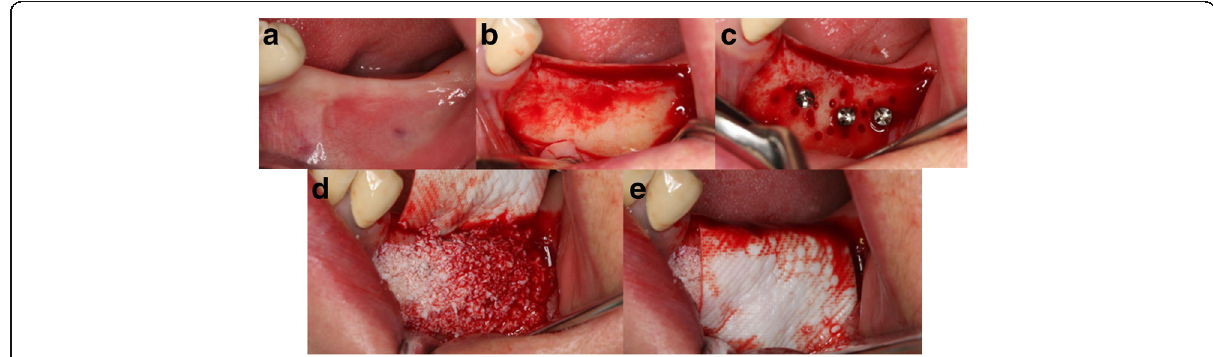
Fig. 1 Intraoral photographs of ridge augmentation using bone graft material and resorbable collagen membrane. a Deficient alveolar ridge. b Mucoperiosteal flap elevation. c Tenting screws installed around the bone grafts. d Bone graft placed. e Resorbable collagen membrane